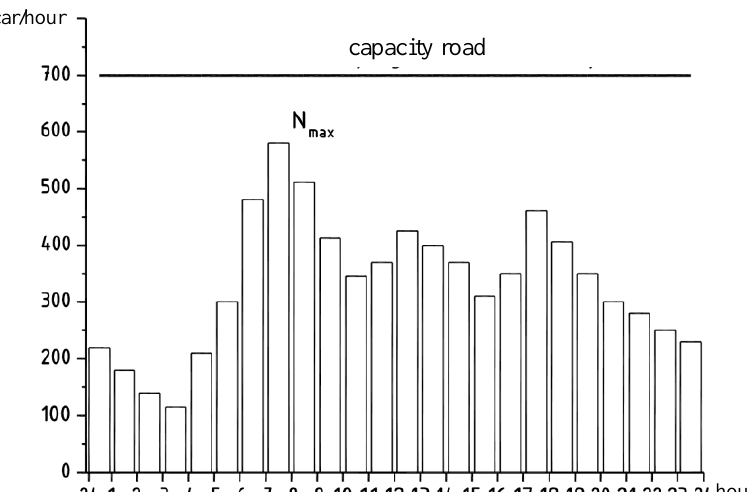
Fig 1. Diagram of hourly traffic distribution on the main road of the cross-road under consideration